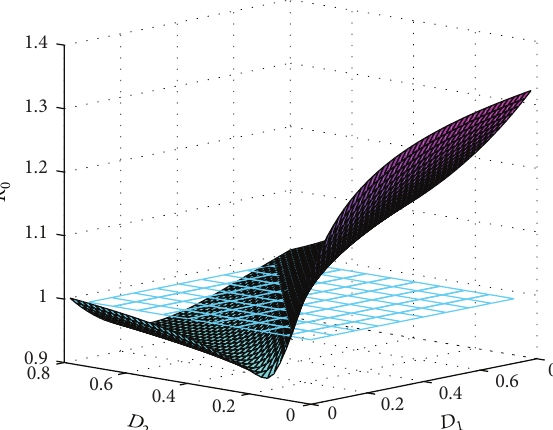
Figure 3: Surface plot of 𝑅 0 as a function of 𝐷 1 and 𝐷 2 for the parameters given in Example